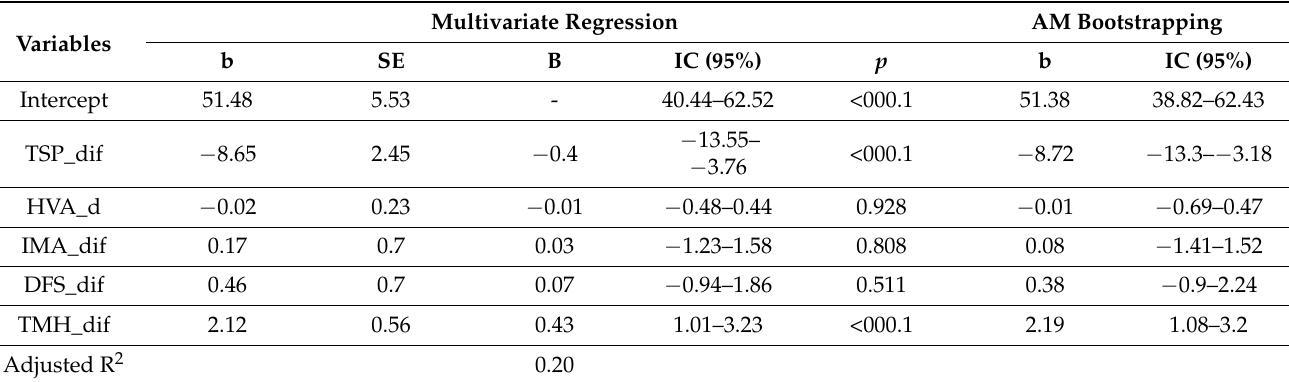
Table 5. Multivariate regression of pre-postoperative AOFAS difference values with the pre- postoperative differences of radiological measures. Pre: Preoperative values. DFS: Distance of the fibular sesamoid bone to the second metatarsal axis. TMH: Translation of the first distal metatarsal head. HVA: Hallux valgus angle. IMA: I–II intermetatarsal angle. TSP : Tibial Sesamoid Position.